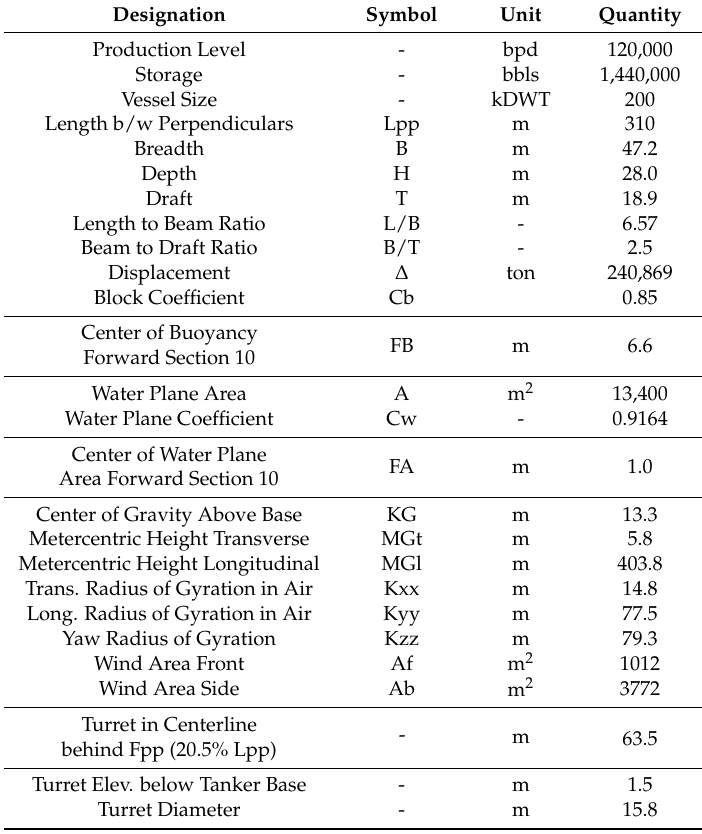
Figure 8. Mesh Generation of the DP FPSO. Figure 8 . Mesh Generation of the DP FPSO. Table 3. Principal Dimension of Simulation Table 3 . Principal Dimension of Simulation Vessel.